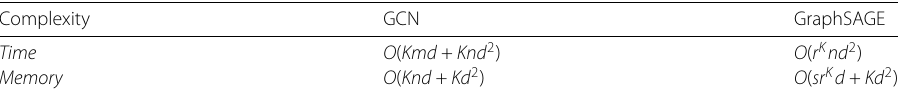
Table 1 Comparison of Complexity of GraphSAGE and Graph Convolutional Networks (GCN) (Adapted from [67]) n is the total number of nodes. m is the total number of edges. K is the number of layers. s is the batch size. r is the number of neighbours being sampled for each node Complexity GCN GraphSAGE